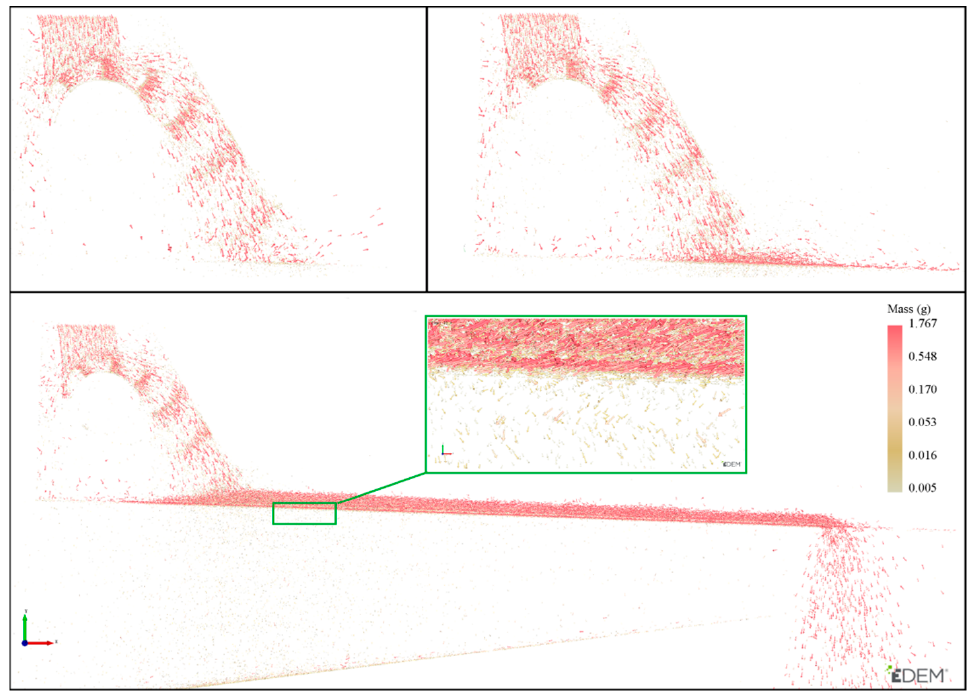
Figure 7. Movement of the particles during the sieving process.